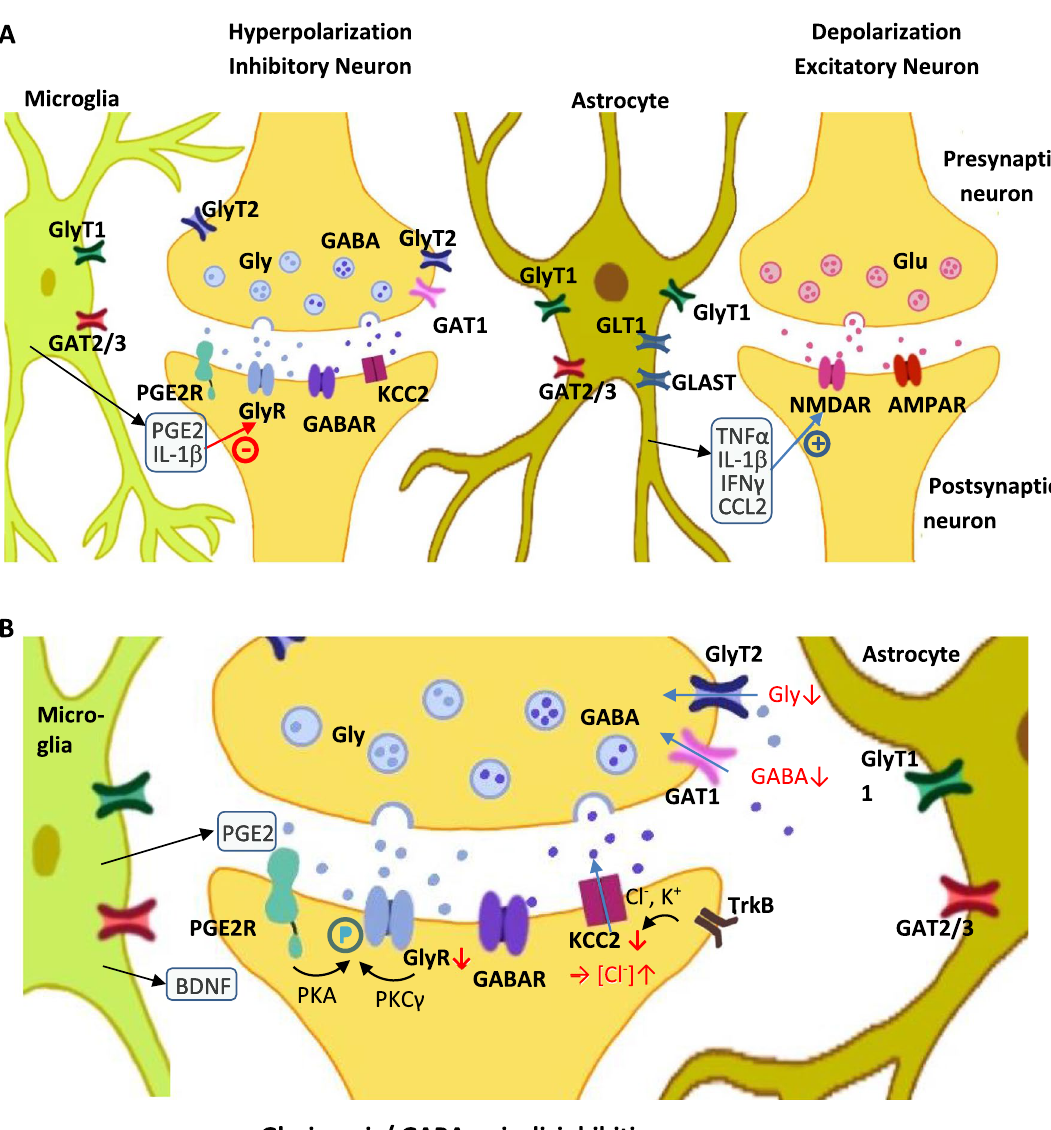
Fig. 2 Central sensitization. A Inhibitory and excitatory synapses. Persistent pain or inflammation causes activation and repetitive firing, which triggers release of the excitatory neurotransmitter glutamate in synapses of the dorsal horn. NMDA receptor activity causes Ca 2 + influx which subsequently can activate intracellular signaling pathways that initiate and maintain central sensitization. In addition, TNF‑α, IL‑1β, IFNγ and CCL2 release activates NMDA receptors, which contribute to persistent depolarization of the cell membrane. Inhibition is performed by glycinergic and GABAergic synapses. B Glycinergic disinhibition: disinhibition is caused by PGE2 release inducing PKA activity and subsequent phosphorylation of GlyR α3, phosphorylation caused by neuronal PKCγ activity also reduces GlyR currents in PKC γ neurons, loss of GlyR activity due to IL‑1β release. Glycine and GABA transporter activity reduces glycine and GABA concentrations in the synaptic cleft, thereby reducing total activity. Release of BDNF inhibits KCC2 cotransporter activity, altering intracellular Cl – concentrations and increasing glycinergic